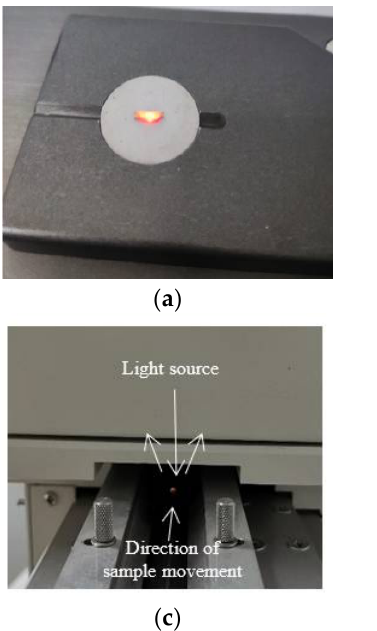
Figure 1. Schematic diagram of diffuse transmission ( a ) and diffuse reflection ( b ) spectral acquisition under static conditions and diffuse reflection ( c ) spectral acquisition under dynamic conditions, and the schematic diagram of rice kernels moving on the conveyor belt ( d ). (Note: In Figure 1c,d, each rice kernel moved horizontally with the conveyor belt. The original spectra were collected continuously when the rice kernels passed through the detection window.).